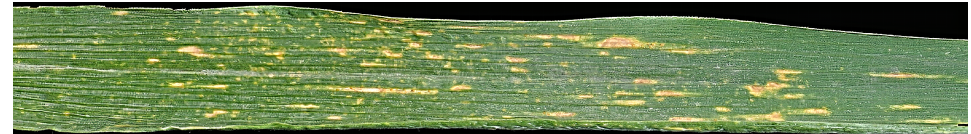
Figure 6. High-resolution image output of